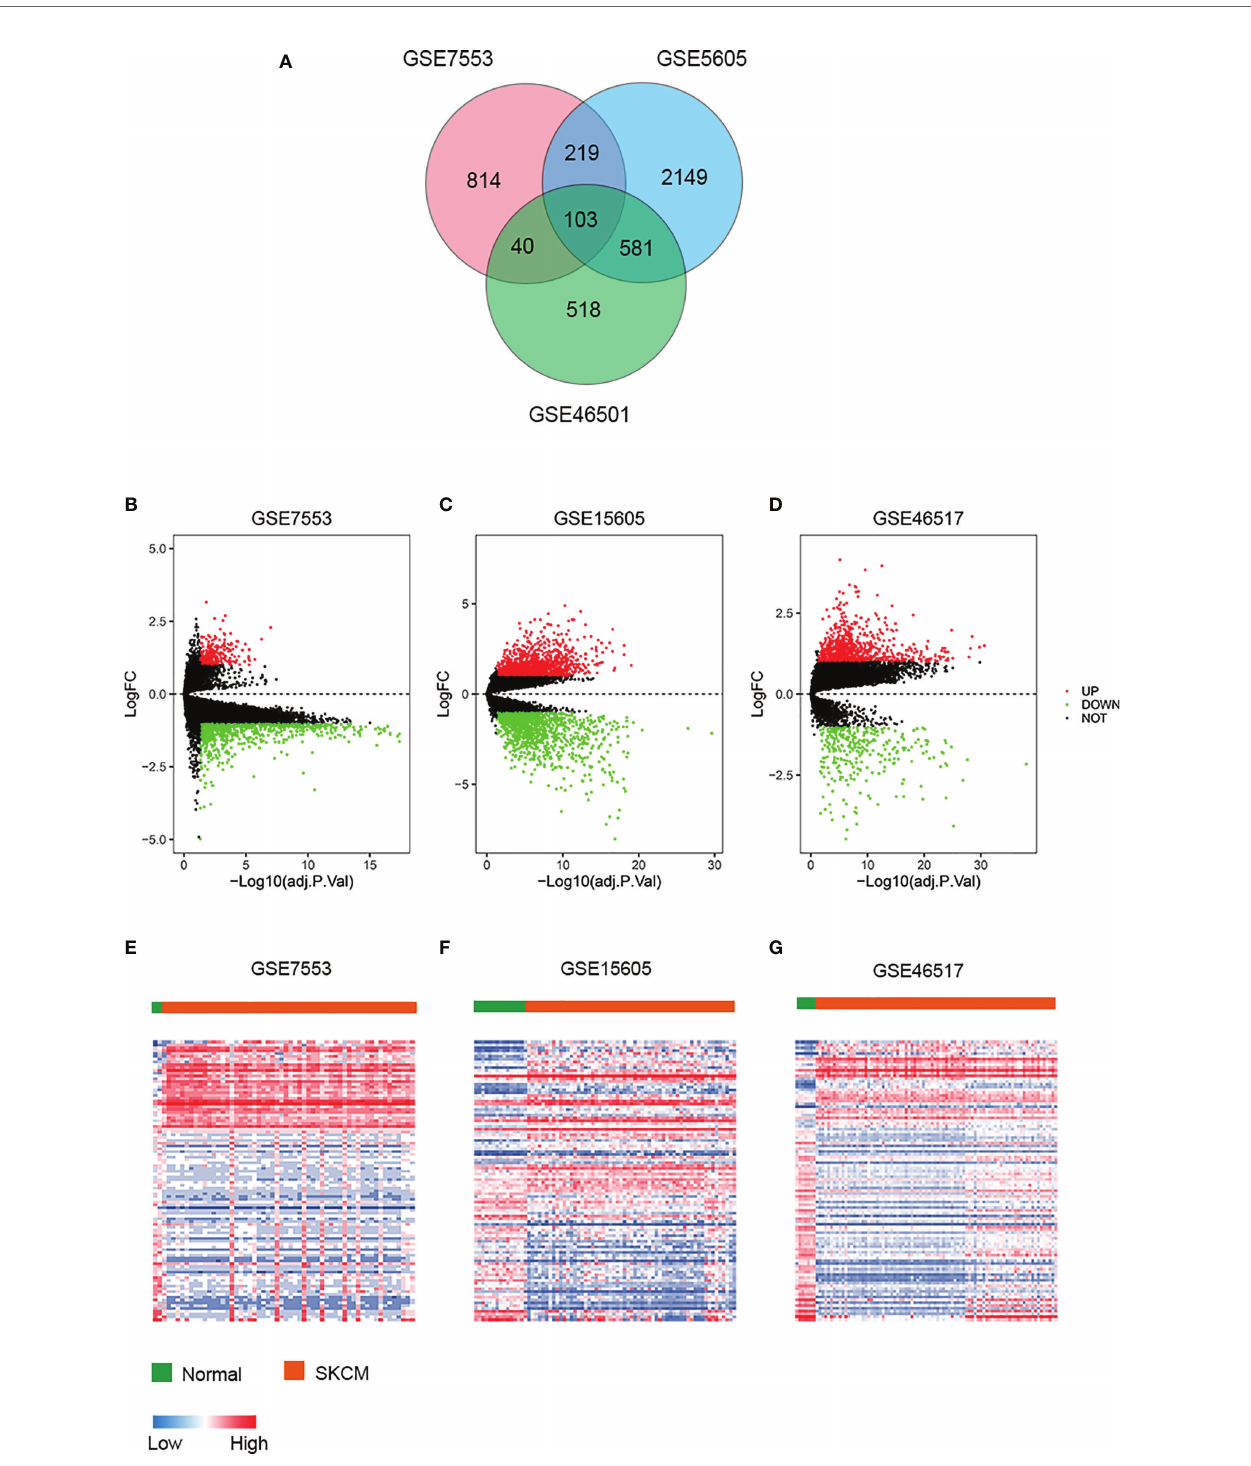
FIGURE 2 | DEGs in three data sets. (A) Venn diagram of DEGs. (B – D) The volcano plots visualize the DEGs in GSE7553, GSE15605, and GSE46517, respectively. The red nodes represent upregulated genes. The green nodes represent downregulated genes. (E – G) Heatmap of the top 103 DEGs according to the value of |logFC| > 1 and FDR < 0.05. The color in heat maps from blue to red shows the progression from low expression to high expression. logFC, log fold